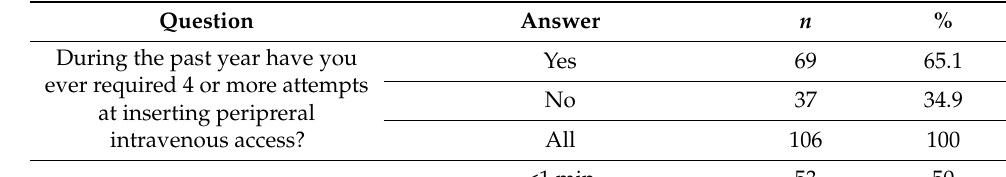
Table 1. Questions regarding previous operator